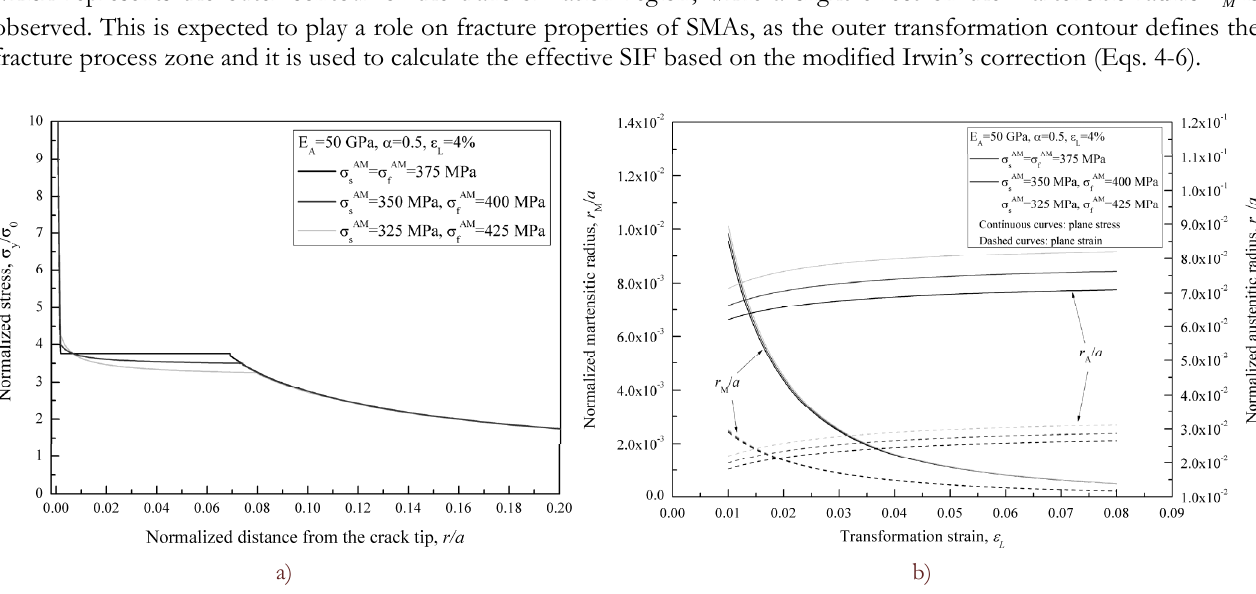
E XPERIMENTAL M